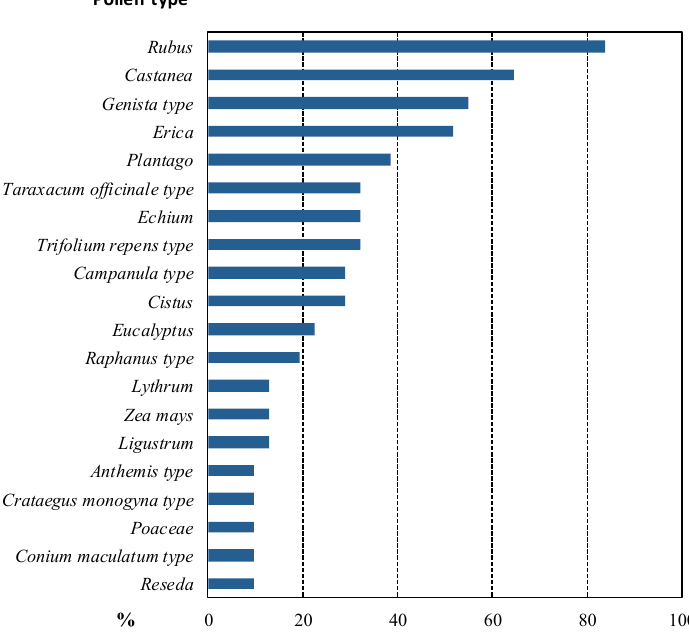
Figure 2. Frequency of the pollen types identified in the bee pollen samples. Table 1. Most ‐ representative families and pollen types in the bee pollen samples produced in Gali ‐ cia.